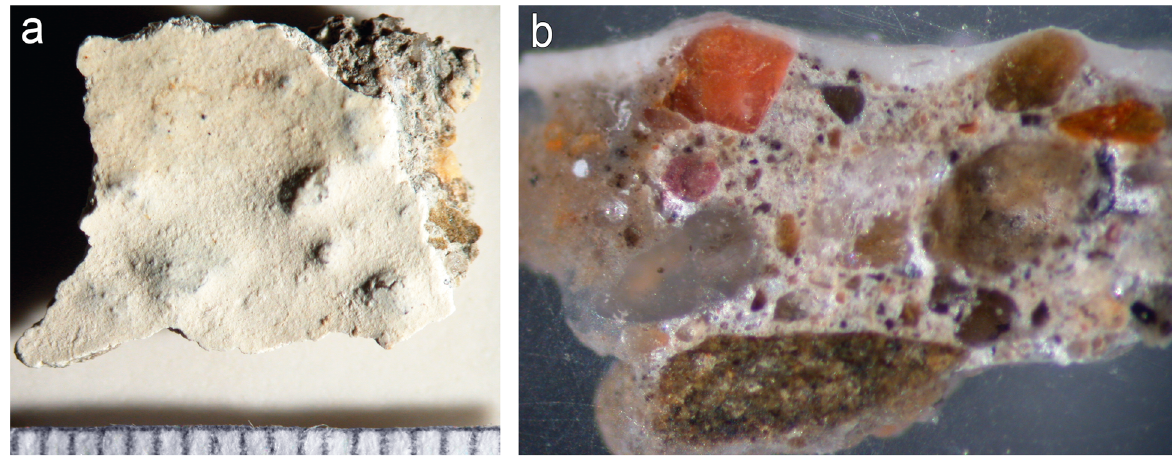
Fig. 10 Tugendhat House, Brno, 1930, samples of the façade plaster. a : macro shot of the original surface of the facade plaster, picture lower edge 13 mm. b : polished section of the facade plaster (Source: study work HAWK / Hildesheim, Ivo Hammer and Christine Hitzler 2004)